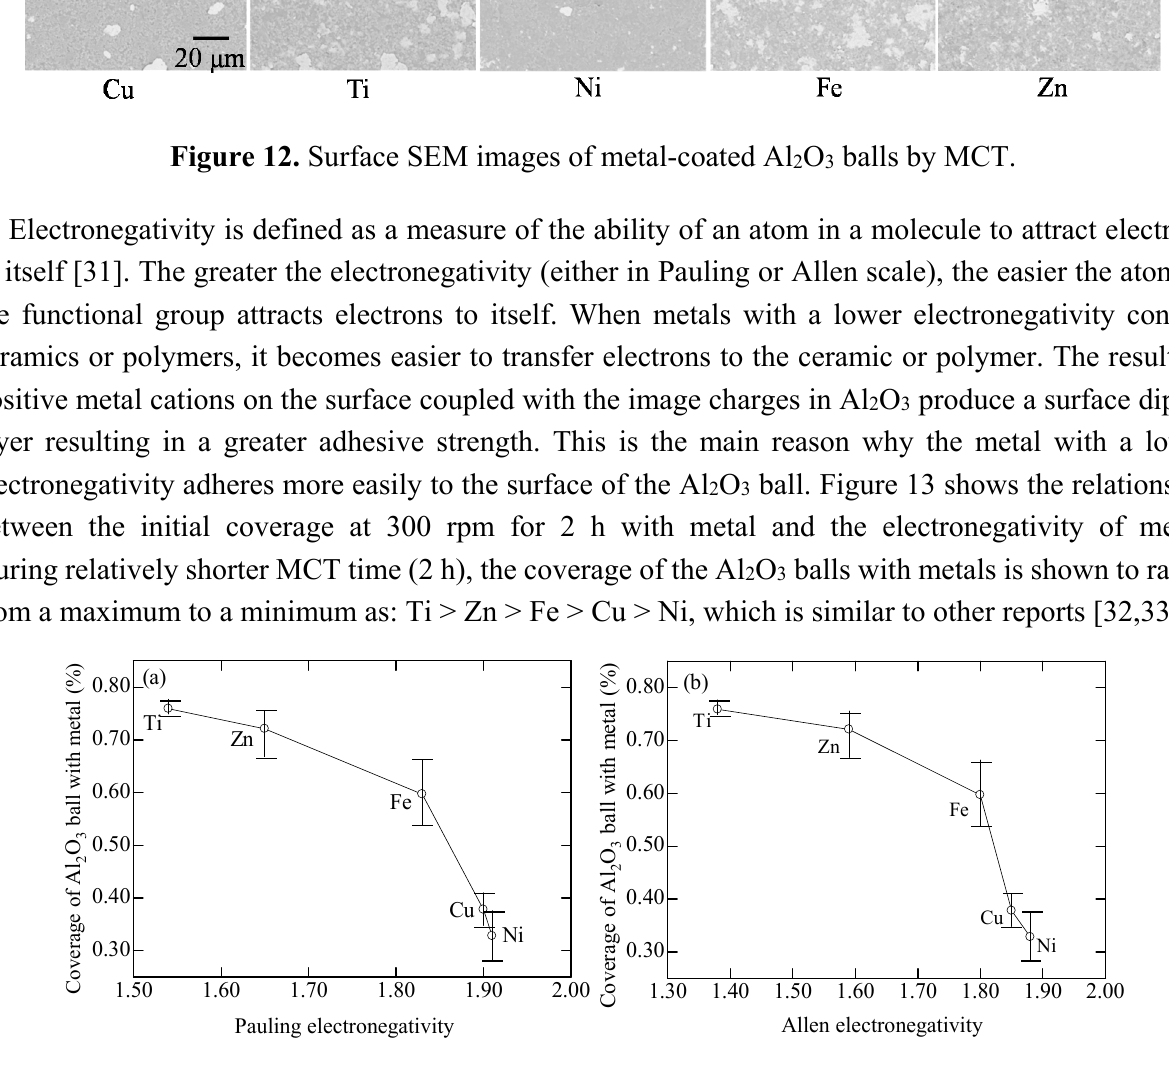
Figure 13. Relationship between coverage of Al 2 O 3 ball with metal and electronegativity of the metal. ( a ) Pauling electronegativity; ( b ) Allen